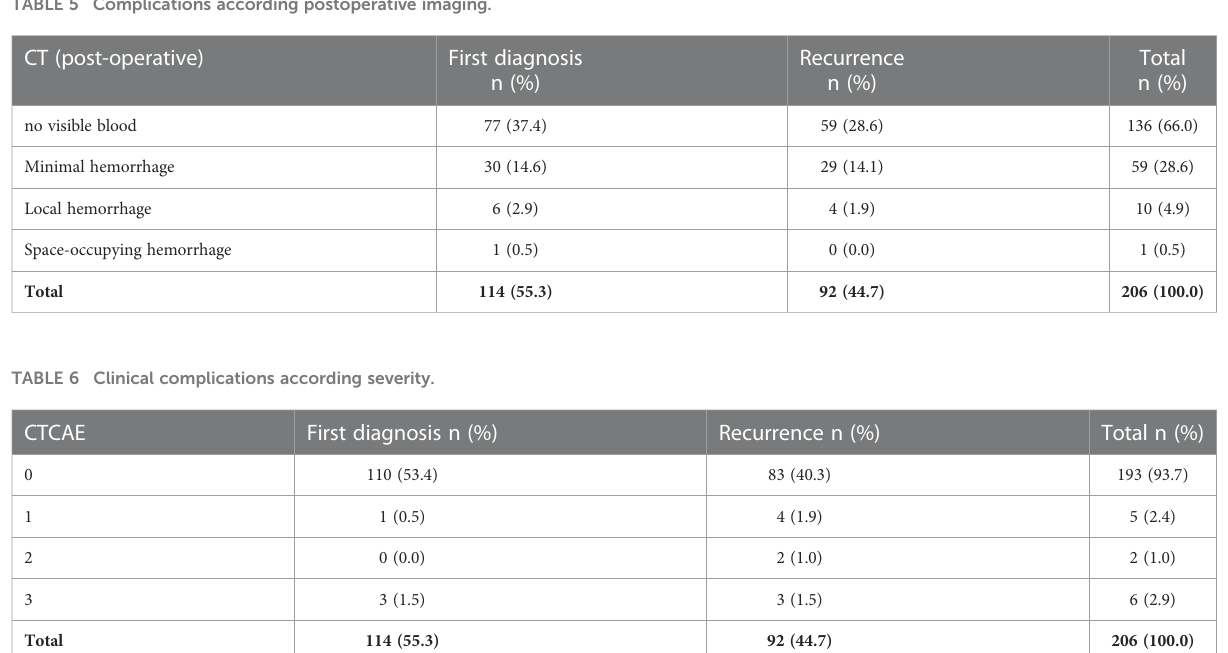
TABLE 5 Complications according postoperative